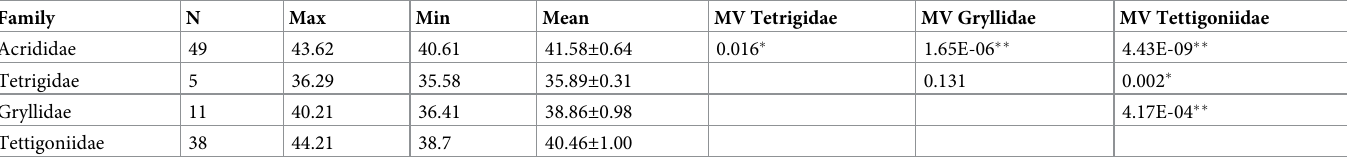
Table 5. A comparison of GC content between genomes of the families Acrididae, Tetrigidae, Gryllidae, and Tettigoniidae. Family